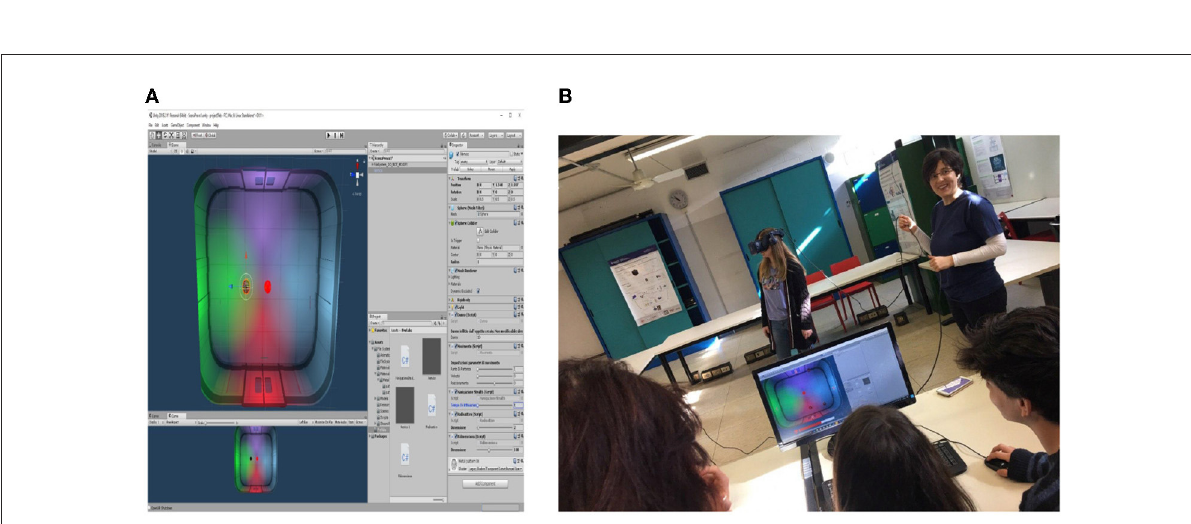
FIGURE6 (A) The Unity interface presented to the attackers’ team: top view of the game and interface to create custom enemies. (B) The VR player tries to dodge the enemies created by the group in the foreground (the attackers).